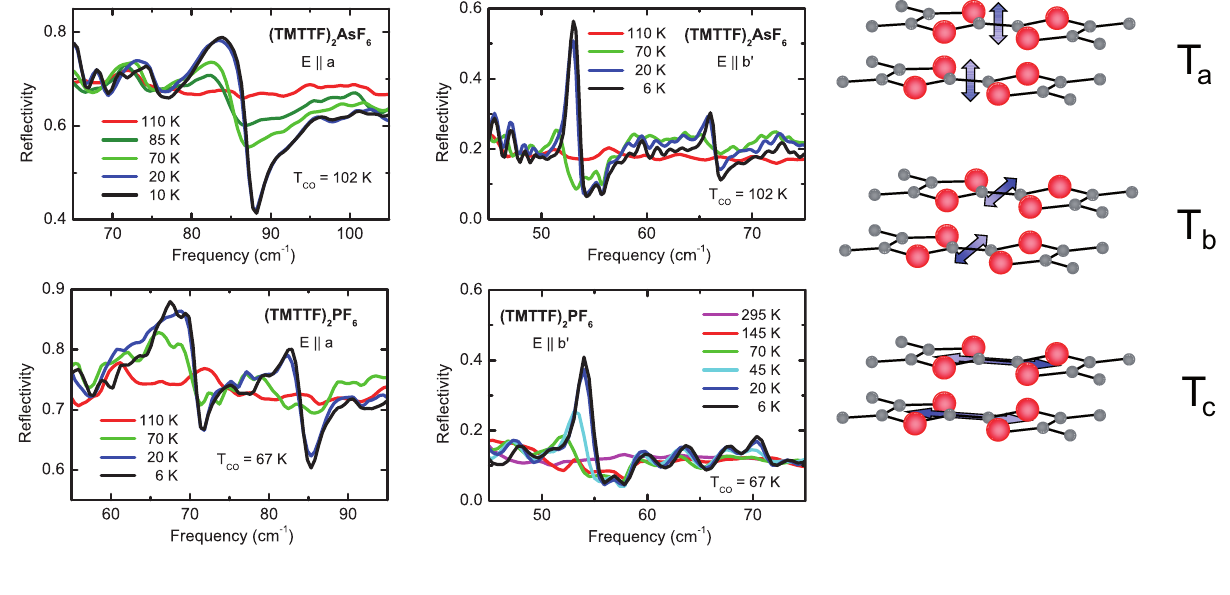
Far-infrared reflectivity spectra of (TMTTF) (TMTTF) PF salts (lower panels) measured at different temperatures with the polarization 2 6 parallel ( E (cid:107) a , left panels) and perpendicular ( E (cid:107) b (cid:48) , right panels) to the stacks. As T drops below T strong vibrational features develop at 54, 66, 75 and 85 cm − 1 in the case of CO (TMTTF) AsF , and at 54, 68, and 83 cm − 1 for (TMTTF) 2 6 related to the translational lattice modes T example of a TMTTF